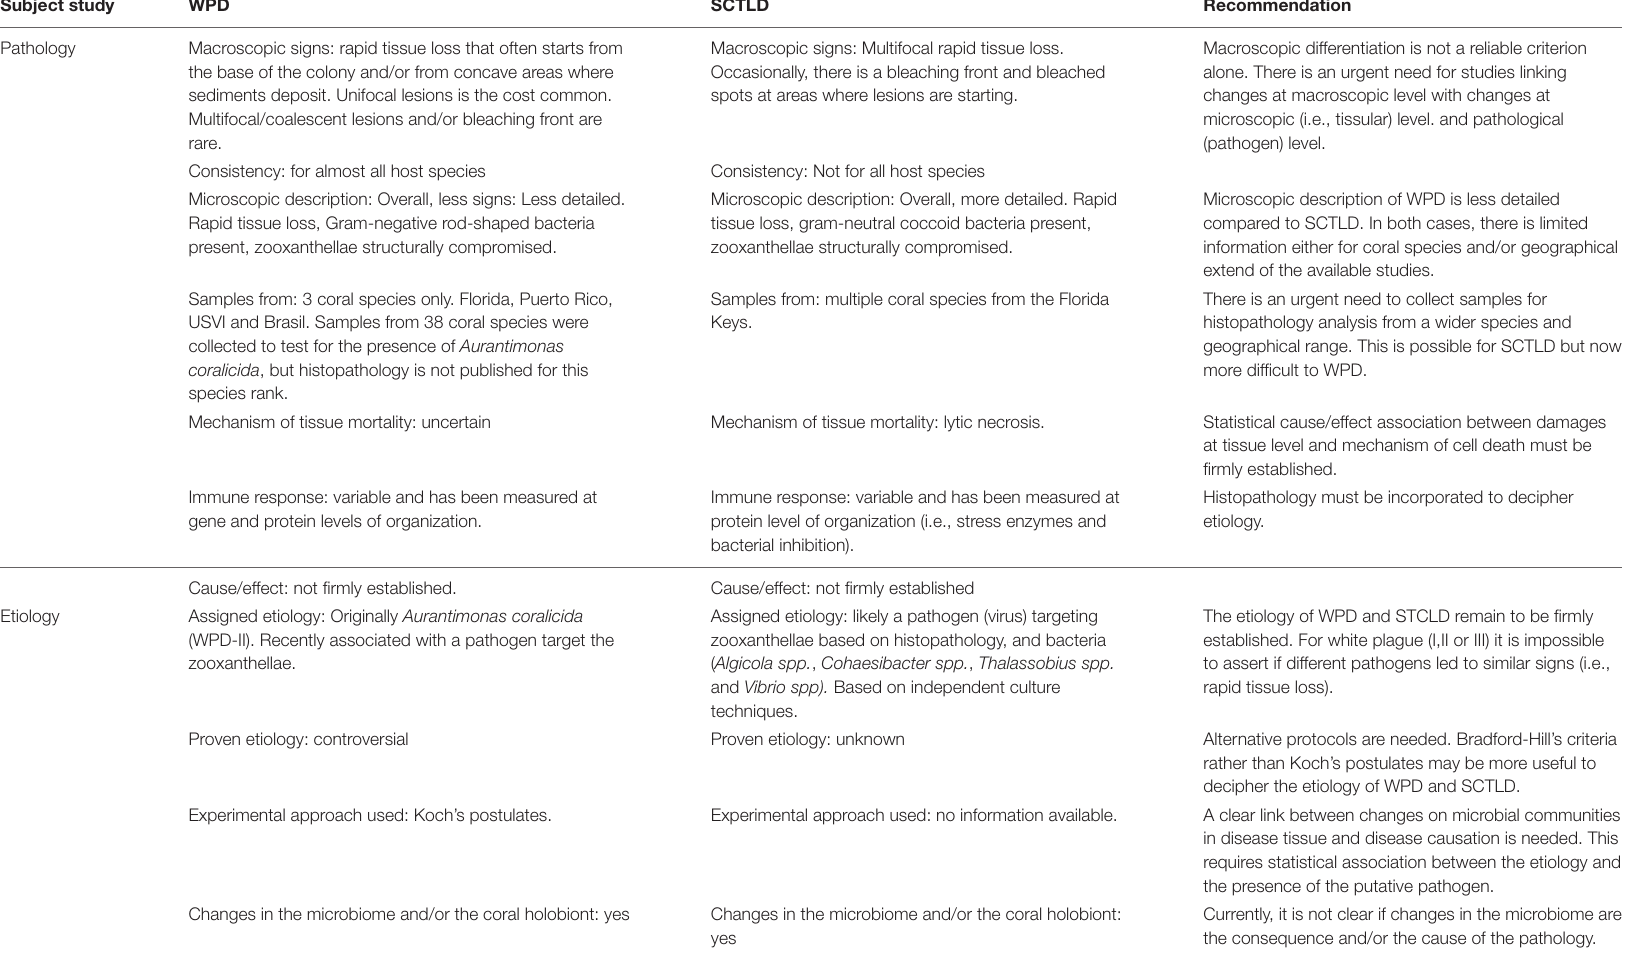
TABLE 1 | Summary of similarities and differences between WPD and SCTLD based on literature review including information displayed in web pages cited along the text. Author credits are already cited and acknowledged throughout the text. Subject study WPD SCTLD Recommendation